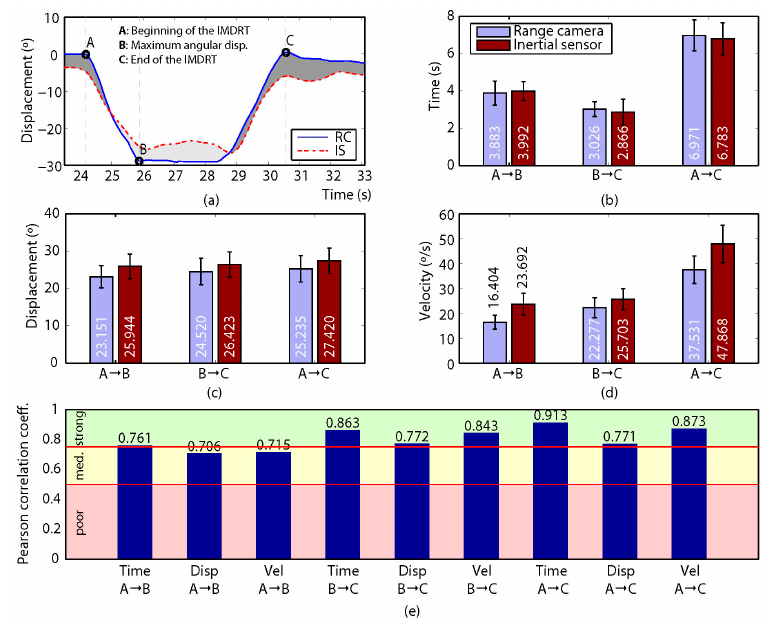
Figure 7. Results for the backward MDRT. ( a ) Comparison of the measured displacement provided by the depth camera (solid blue) and the inertial sensor (dashed red) for a representative participant. The positions of the defined control points are also shown; ( b , c , d ) mean time (with CI 95%), mean angular displacement (with CI 95%) and mean angular velocity (with CI 95%), respectively, over all the participants for the intervals defined by the control points; ( e ) Pearson Correlation Coefficient (r) (p < 0.005) between the devices for all the measured variables. (Time is expressed in seconds, angular displacement in degrees, and angular velocity in degrees per second).